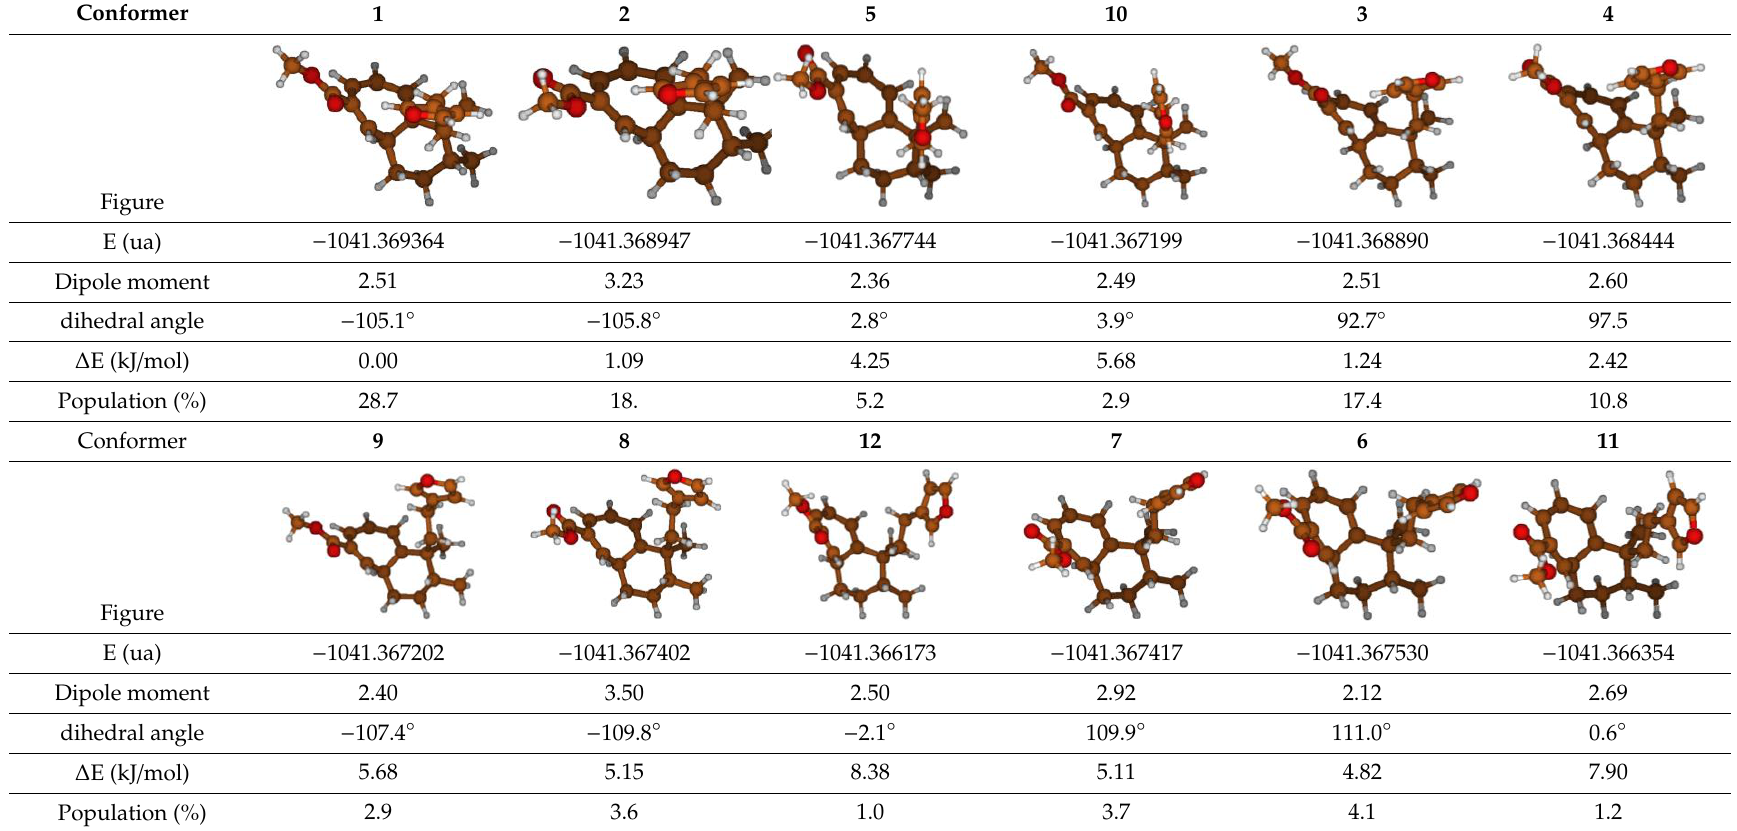
Table 10. Calculated B3LYP / 6-311 + G(d,p) Energies a , Dipole moments (Debye), relatives Energies a , (C13-C14-C15-C18) dihedral angle, equilibrium population at 25 ◦ C Table 10. Calculated B3LYP/6-311+G(d,p) Energies a , Dipole moments (Debye), relatives Energies a , (C13-C14-C15-C18) dihedral angle, equilibrium population at Table 10. Calculated B3LYP/6-311+G(d,p) Energies a , Dipole moments (Debye), relatives Energies a , (C13-C14-C15-C18) dihedral angle, equilibrium population at Table 10. Calculated B3LYP/6-311+G(d,p) Energies a , Dipole moments (Debye), relatives Energies a , (C13-C14-C15-C18) dihedral angle, equilibrium population at Table 10. Calculated B3LYP/6-311+G(d,p) Energies a , Dipole moments (Debye), relatives Energies a , (C13-C14-C15-C18) dihedral angle, equilibrium population at Table 10. Calculated B3LYP/6-311+G(d,p) Energies a , Dipole moments (Debye), relatives Energies a , (C13-C14-C15-C18) dihedral angle, equilibrium population at Table 10. Calculated B3LYP/6-311+G(d,p) Energies a , Dipole moments (Debye), relatives Energies a , (C13-C14-C15-C18) dihedral angle, equilibrium population at and figures of conformations 1-12 of the 1 S , 8 S , 9 R isomer of methyl iso-dodovisate A ( 3 ). 25°C and figures of conformations 1-12 of the 1 S , 8 S , 9 R isomer of methyl iso-dodovisate A ( 3 ). 25°C and figures of conformations 1-12 of the 1 S , 8 S , 9 R isomer of methyl iso-dodovisate A ( 3 ). 25°C and figures of conformations 1-12 of the 1 S , 8 S , 9 R isomer of methyl iso-dodovisate A ( 3 ). Table 10. Calculated B3LYP/6-311+G(d,p) Energies a , Dipole moments (Debye), relatives Energies a , (C13-C14-C15-C18) dihedral angle, equilibrium population at Table 10. Calculated B3LYP/6-311+G(d,p) Energies a , Dipole moments (Debye), relatives Energies a , (C13-C14-C15-C18) dihedral angle, equilibrium population at Table 10. Calculated B3LYP/6-311+G(d,p) Energies a , Dipole moments (Debye), relatives Energies a , (C13-C14-C15-C18) dihedral angle, equilibrium population Table 10. Calculated B3LYP/6-311+G(d,p) Energies a , Dipole moments (Debye), relatives Energies a , (C13-C14-C15-C18) dihedral angle, equilibrium population at Table 10. Calculated B3LYP/6-311+G(d,p) Energies a , Dipole moments (Debye), relatives Energies a , (C13-C14-C15-C18) dihedral angle, equilibrium population at Table 10. Calculated B3LYP/6-311+G(d,p) Energies a , Dipole moments (Debye), relatives Energies a , (C13-C14-C15-C18) dihedral angle, equilibrium population at 25°C and figures of conformations 1-12 of the 1 S , 8 S , 9 R isomer of methyl iso-dodovisate A ( 3 ).